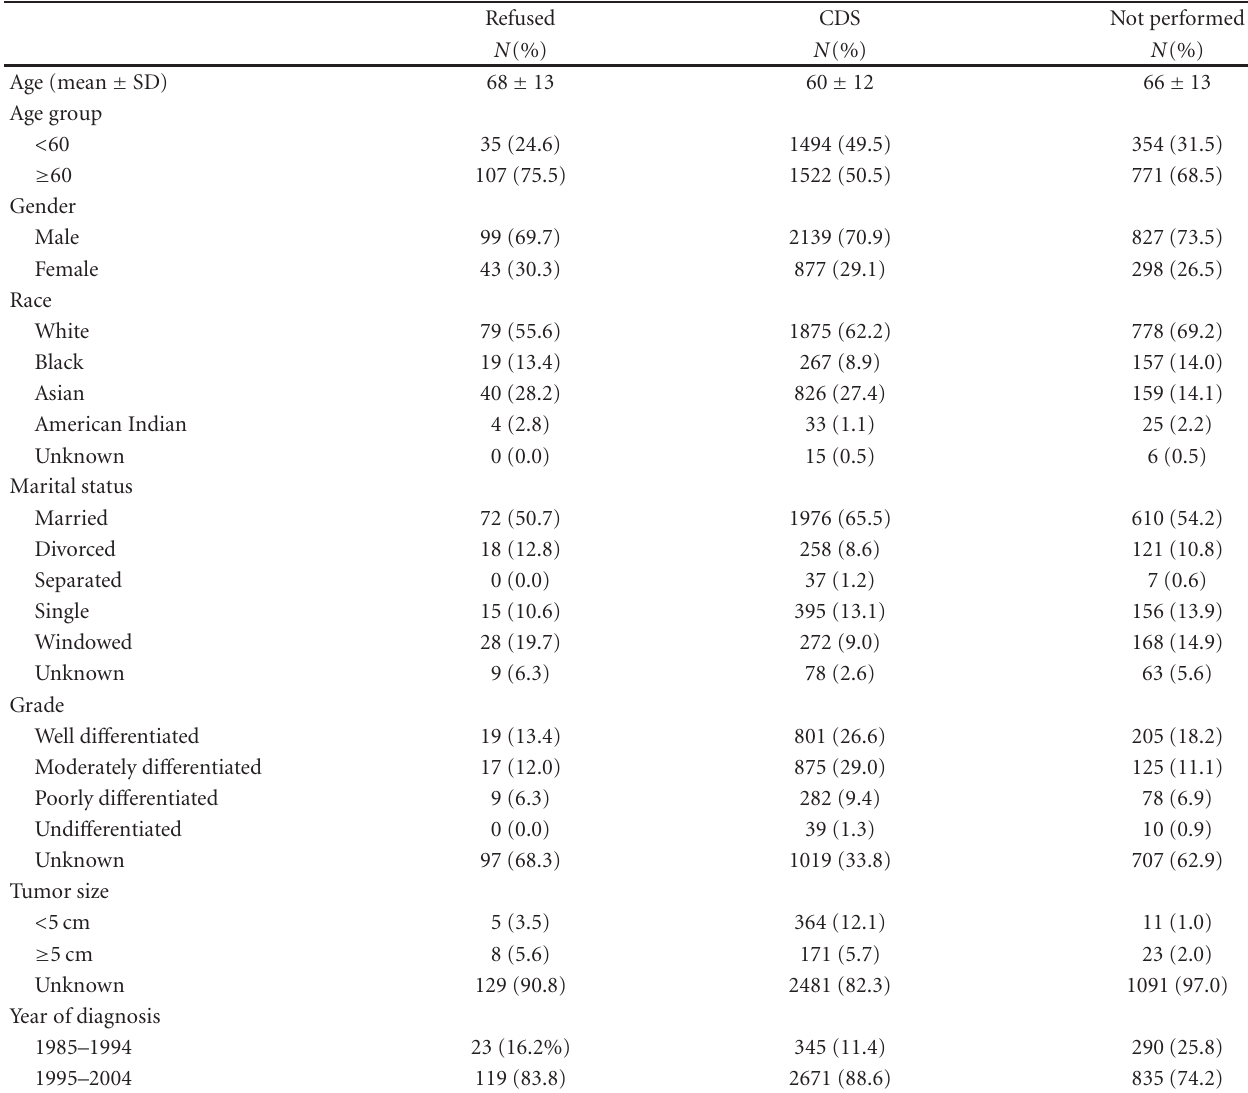
Table 2: Comparison of patients with localized HCC who had, with those who, refused CDS, and those CDS were not performed due to unknown reason. CDS: cancer-directed